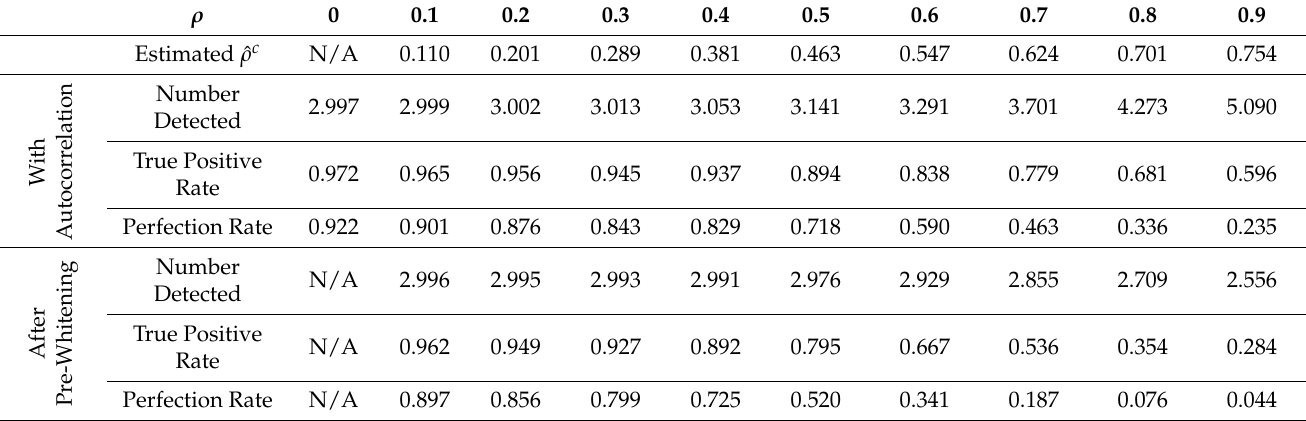
Table 2. Autocorrelation in a Change Point Model with Linear Trend. A total of 1000 datasets containing a linear trend with 3 change points were generated for each value of the autocorrelation parameter, ρ . The average number of change points detected by the Bayesian change point model before and after pre-whitening is indicated for each value of ρ in addition to the true positive and perfection rate. Note that a value of ρ = 0 corresponds to white